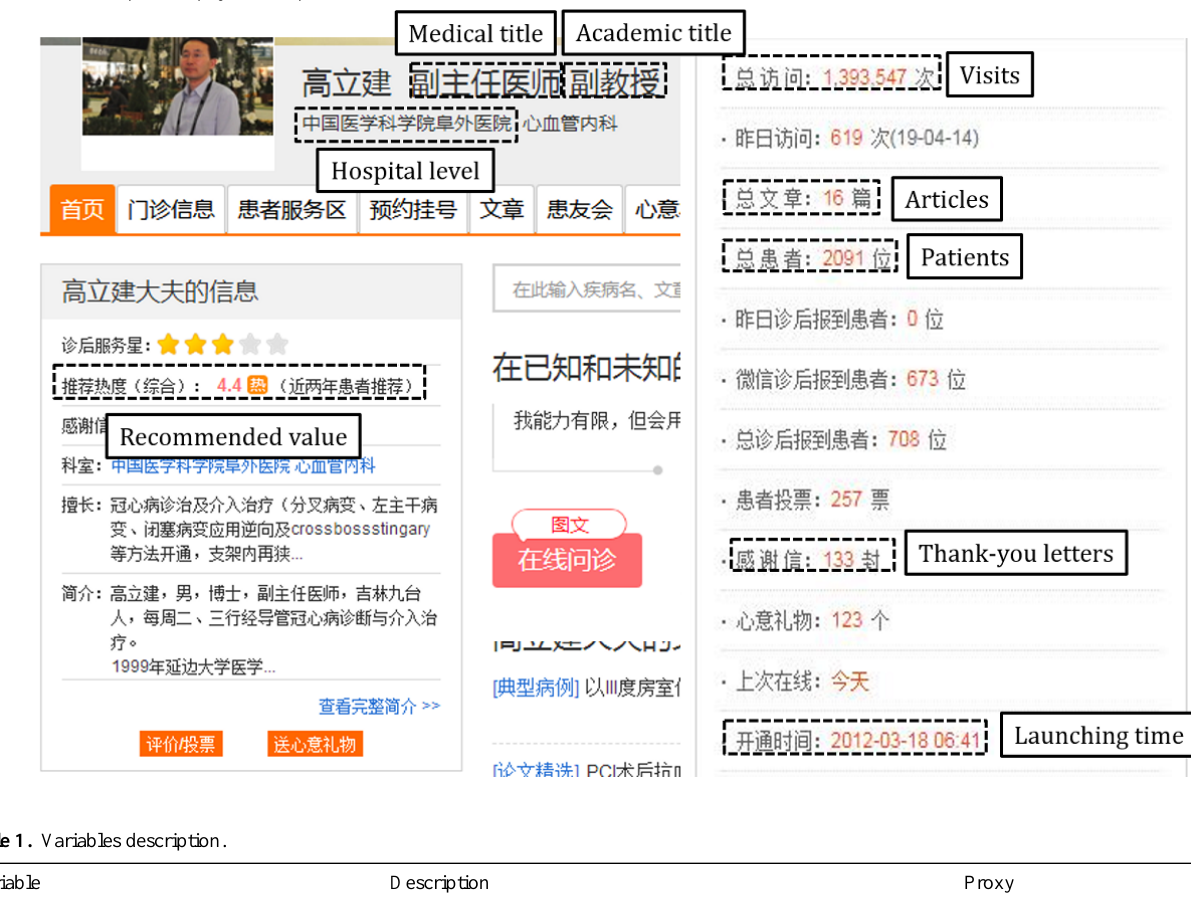
Figure 3. An example of a physician’s personal website.